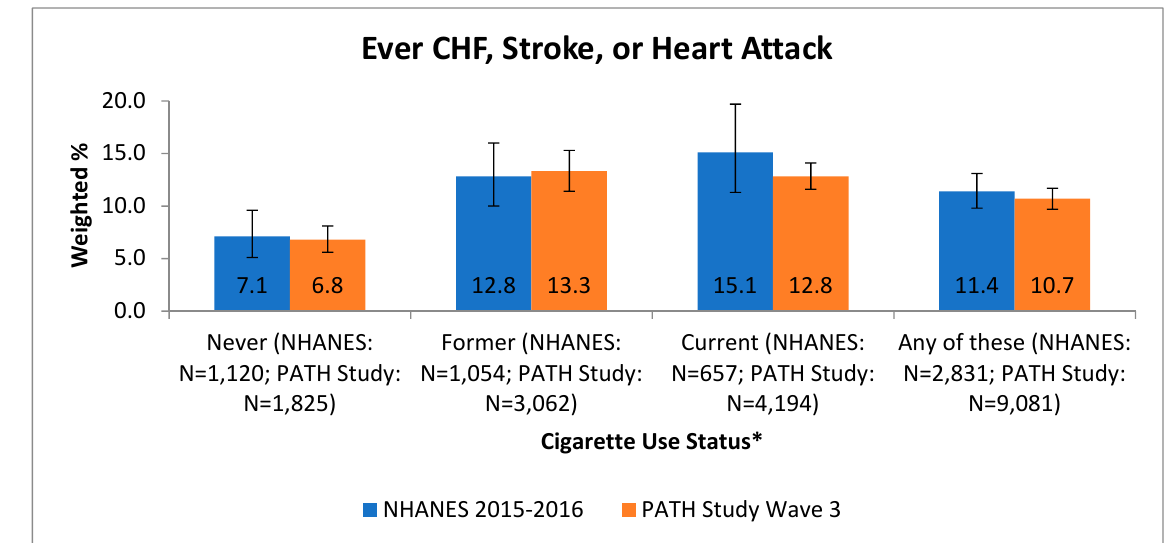
Figure 1. Comparison of PATH Study heart condition prevalence with NHANES self-reported prevalence by tobacco user group and overall, age 40+. * NHANES: never: never smoked a cigarette, even one time; former: smoked at least 100